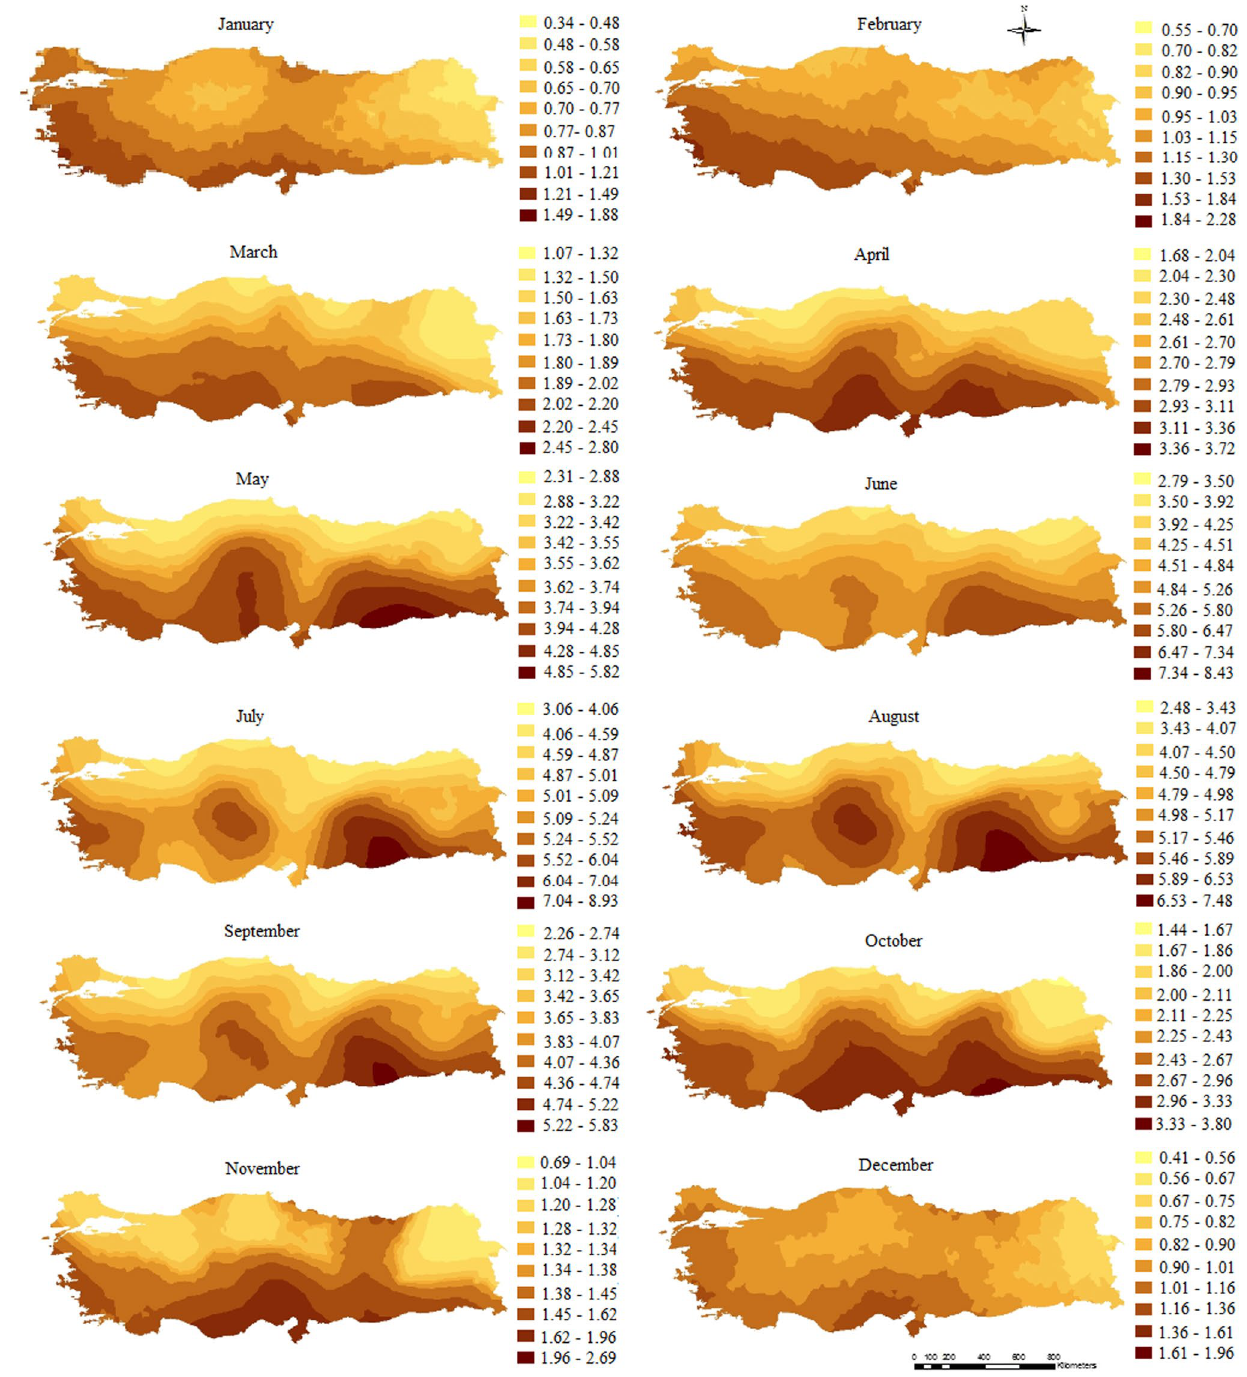
Fig. 7 Spatial distribution maps of OK-predicted daily ET